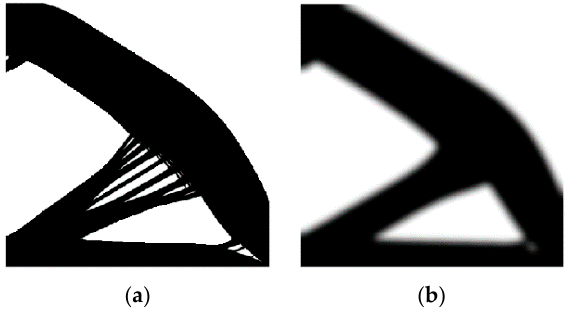
Figure 14. Final topology obtained using [37] with a small ( a ) and a large ( b ) filtering radius.